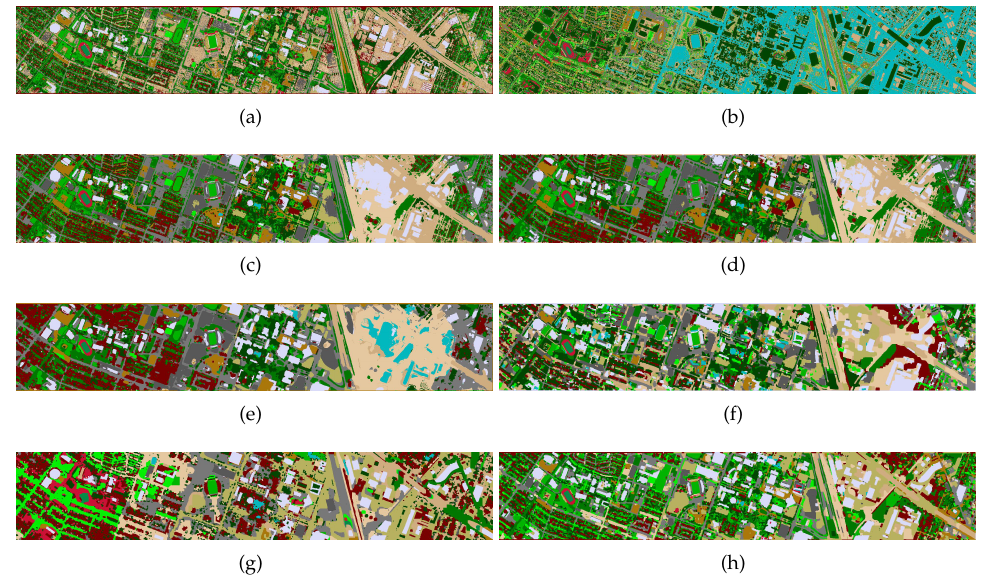
Figure 7. Visual maps obtained by different approaches on Houston 2013 dataset. ( a ) MLR on HSI. ( b ) MLR on LiDAR. ( c ) OTVCA. ( d ) SSLRA. ( e ) SubFus. ( f ) Our method on HSI. ( g ) Our method on LiDAR. ( h ) Our